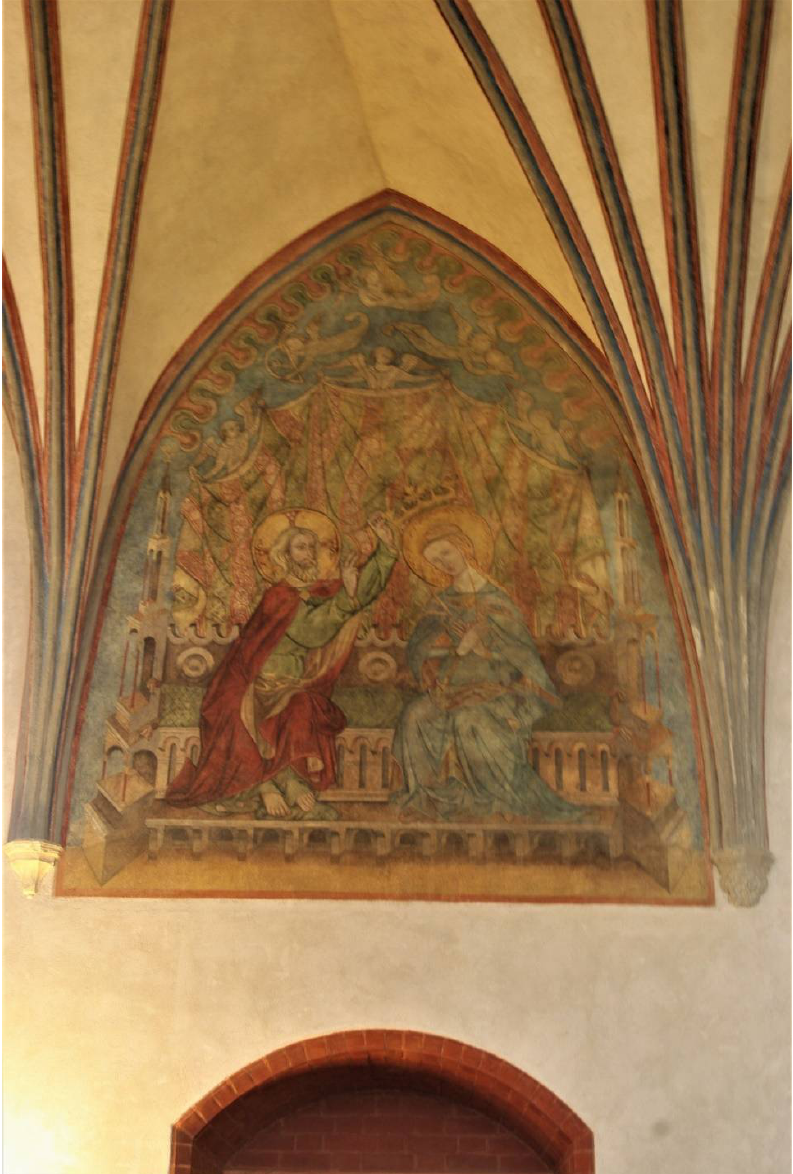
Figure 14. Malbork, Marienburg castle, Grand Refectory. Coronation of Mary, probably the second half of the 14th century. Photo by Tomasz Ratajczak, the author’s own work.